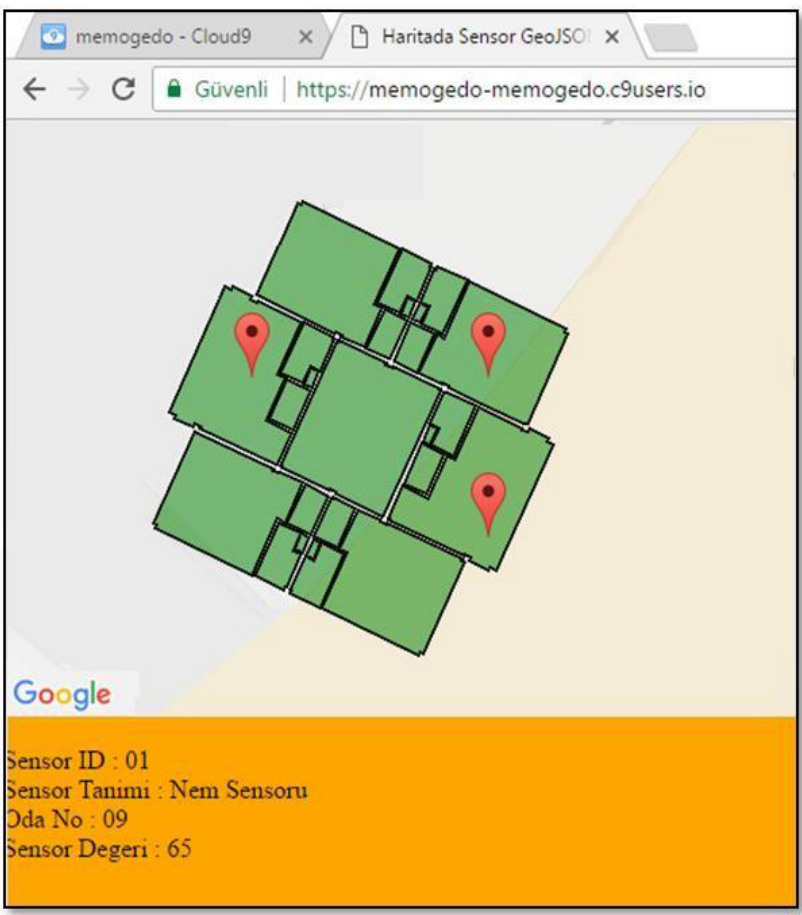
Figure 5. Visualization of Integrated